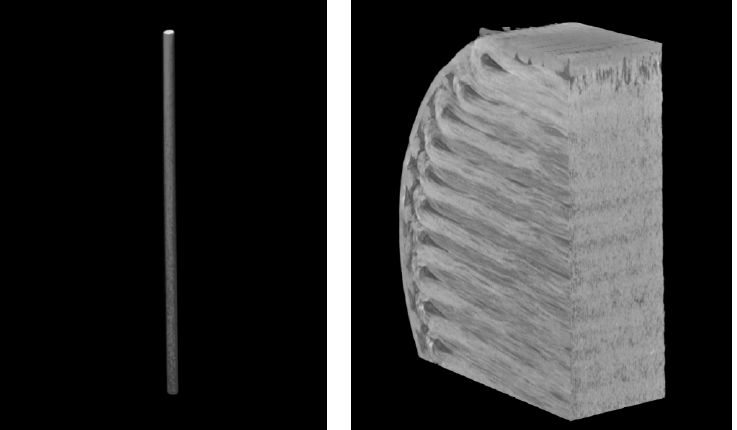
Figure 13. Micrograph of a single carbon fibre and cross-section of a through-thickness sample.